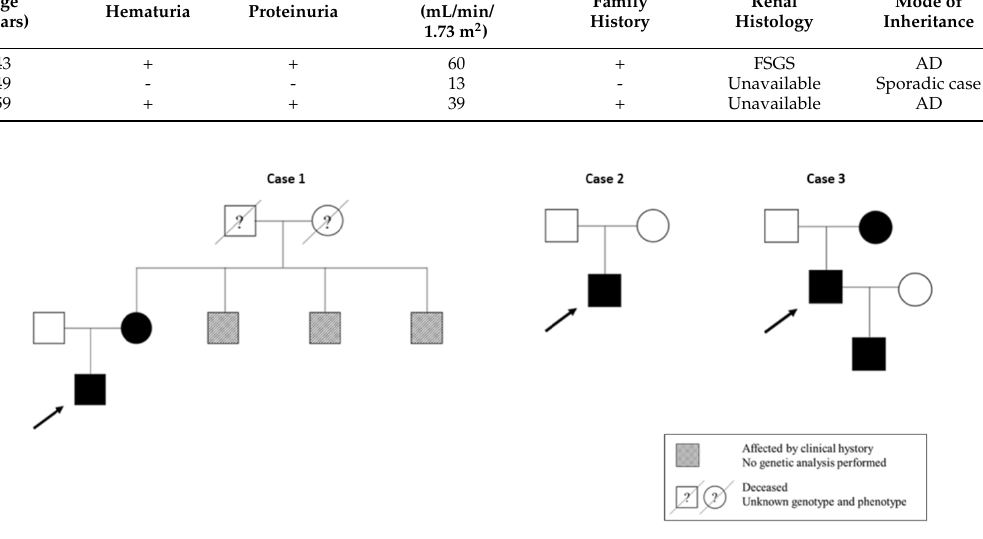
Figure 3. Genealogical trees of COL4 patients. The arrows indicate the index cases.